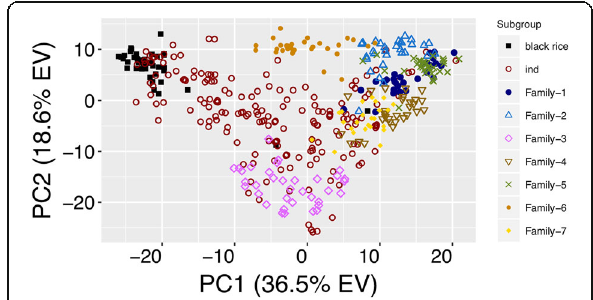
Fig. 3 Principal component analysis of 431 O. sativa S. indica accessions using the 1k-RiCA genotypic data. PCA on 431 ‘ Indica ’ accessions including 177 diverse lines ( ind ), 41 ‘ black rice ’ (black rice), and 213 lines derived from 7 bi-parental families from IRRI ’ s Favorable Environments Breeding Program (Family). Diverse lines were color and coded as open maroon circles ('ind' - indica ), as solid black squares ('black rice'). Elite breeding lines were classified by family ( ‘ Family ’ ) based on their pedigree data. Blue dots ('Family-1'), open blue triangles ('Family-2'), open magenta diamonds ('Family-3'), open inverted brown triangles ('Family-4'), green crosses ('Family-5'), ochre dots ('Family-6') and yellow diamonds ('Family-7')